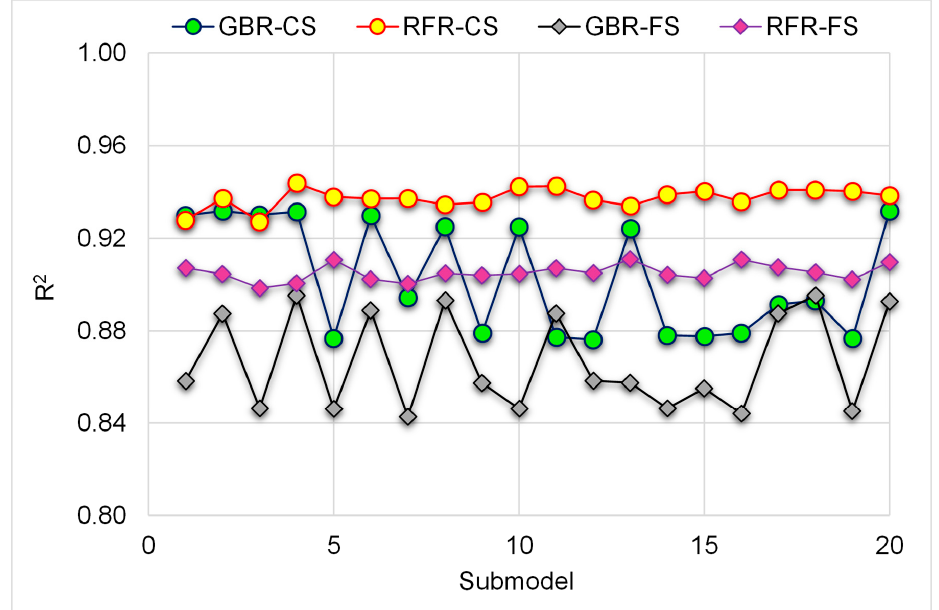
Figure 15. Distribution of R 2 for the utilized ML models.